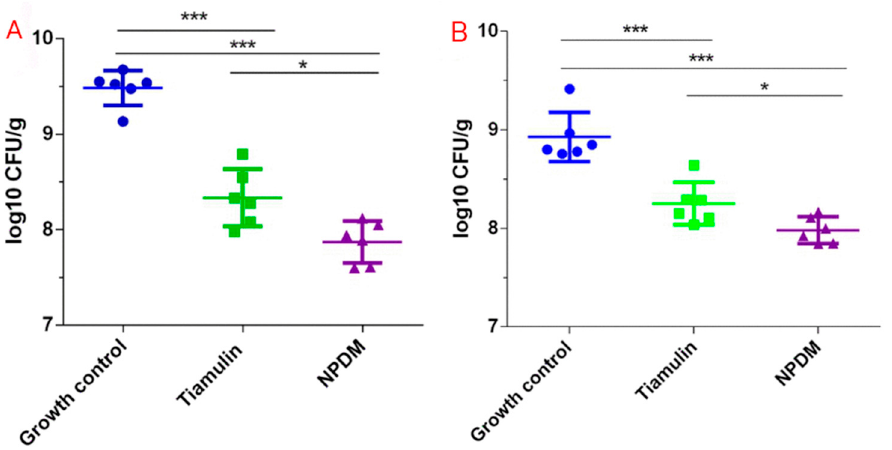
Figure 5. Efficacy of tiamulin (20 mg/kg) and NPDM (20 mg/kg) against MRSA ATCC 43300 in mouse neutropenic thigh models ( A ). NPDM vs. growth control, ***; tiamulin vs. growth control, ***; NPDM vs. tiamulin, *. Efficacy of tiamulin (20 mg/kg) and NPDM (20 mg/kg) against S. aureus ATCC 29213 in mouse neutropenic thigh models ( B ). NPDM vs. growth control, ***; tiamulin